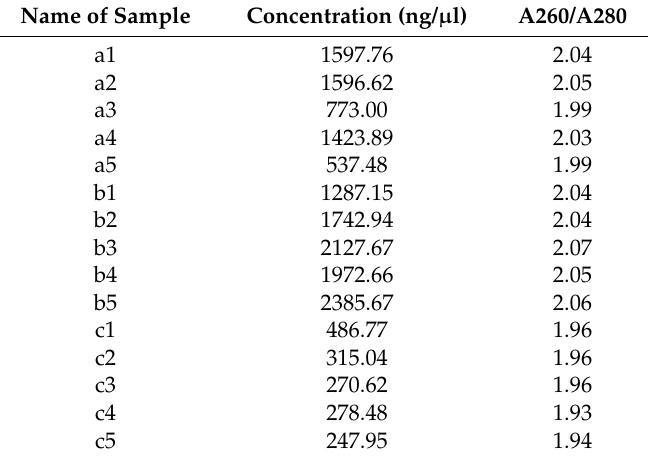
Figure 6. Agarose gel electrophoresis of RNA of zebrafish three tissues. a1–a5 gill tissues; b1-b5 liver tissues; c1–c5 intestine tissues; 1–5 represent different group. Table 3. The concentration of RNA from three different tissues.